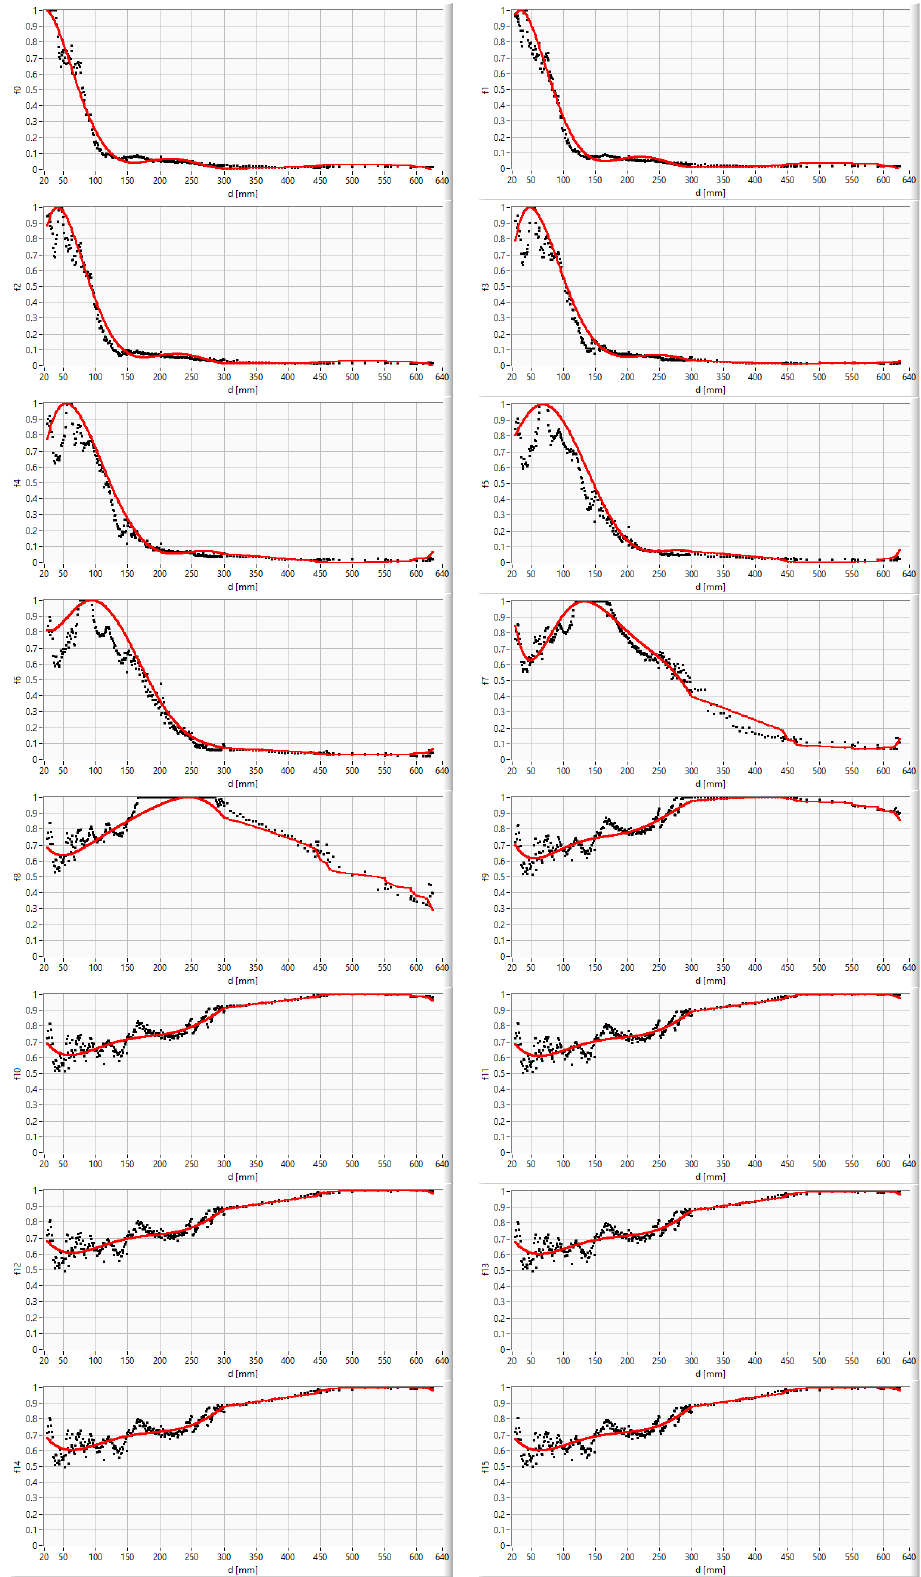
Figure 3. Polynomial approximations of clarities to the position of the object, for each of the 16 focus lens’ positions (f 0 – f 15 ).